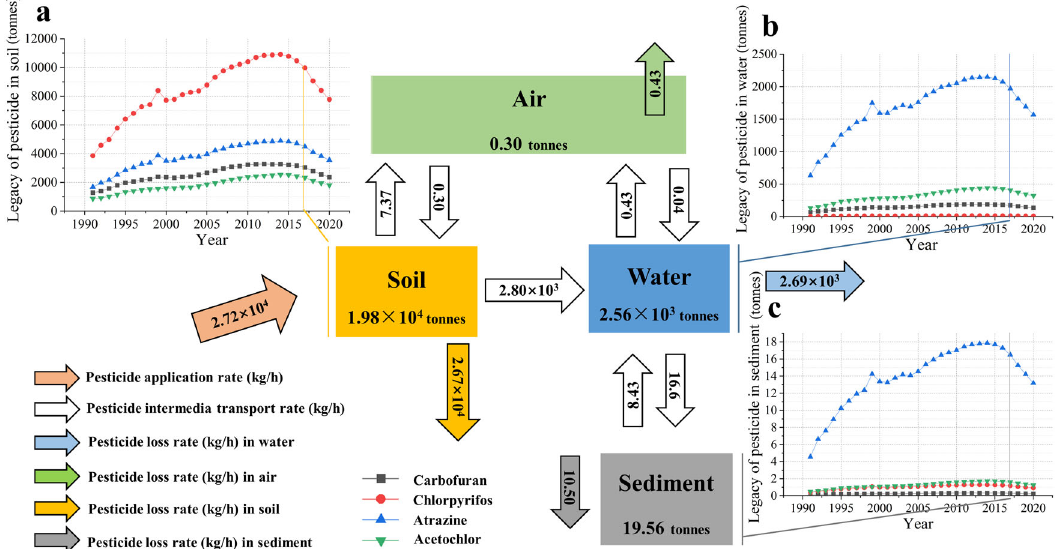
Fig. 1 Schematic diagram of transport and legacy of target pesticides in multimedia. Transmission rate is calculated as the overall rate of target pesticides in all basin units at the end of 2017. Legacy of four target pesticides per year in soil, water and sediment was shown in a , b , and c